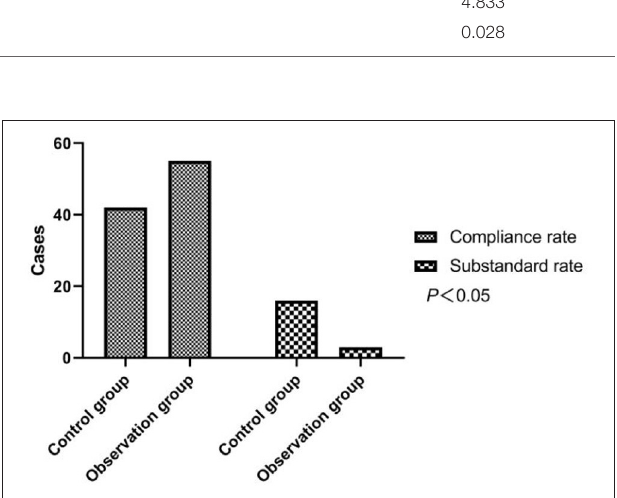
FIGURE 1 | Comparison of health knowledge mastery between two groups of